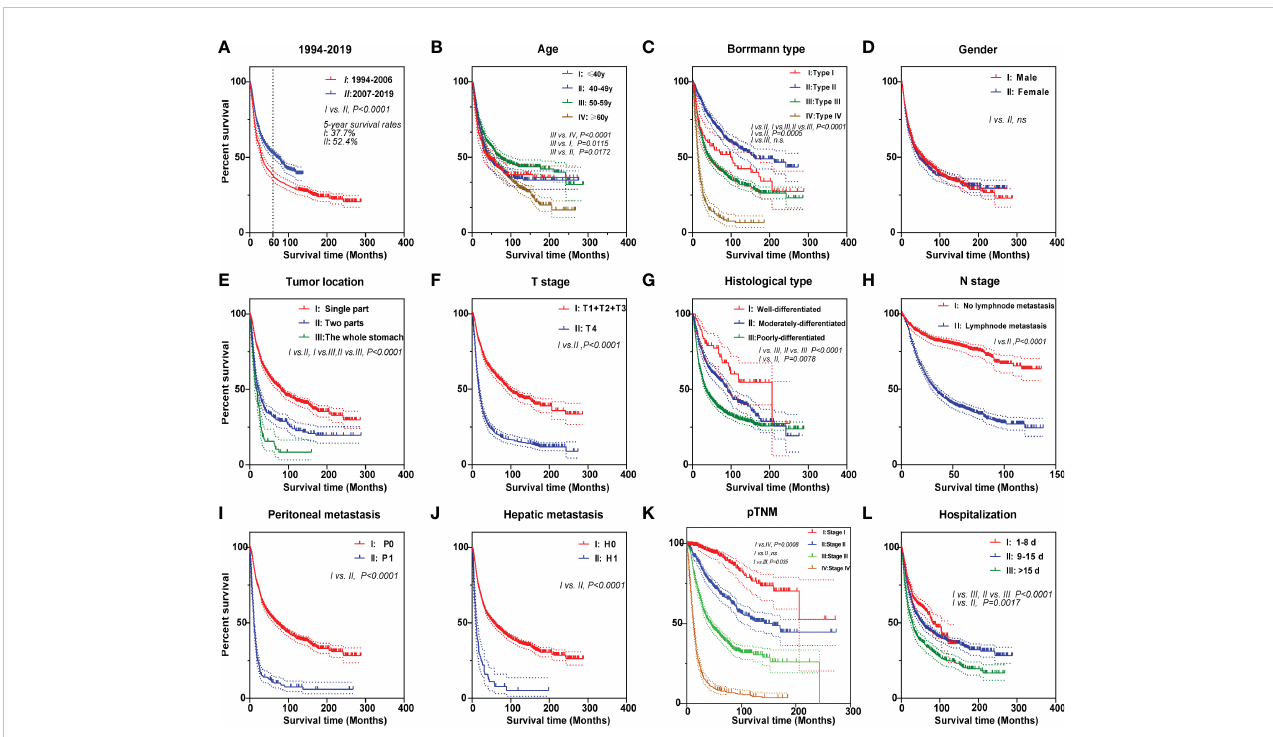
FIGURE 2 Kaplan – Meier survival curves of gastric cancer patients for different prognostic factors. The curves according to (A) two 13-year periods, (B) age, (C) Borrmann type, (D) gender, (E) tumor location, (F) T stage, (G) histological type, (H) N stage, (I) peritoneal metastasis, (J) hepatic metastasis, (K) pTNM, and (L) hospitalization. Log-rank was used to compare the